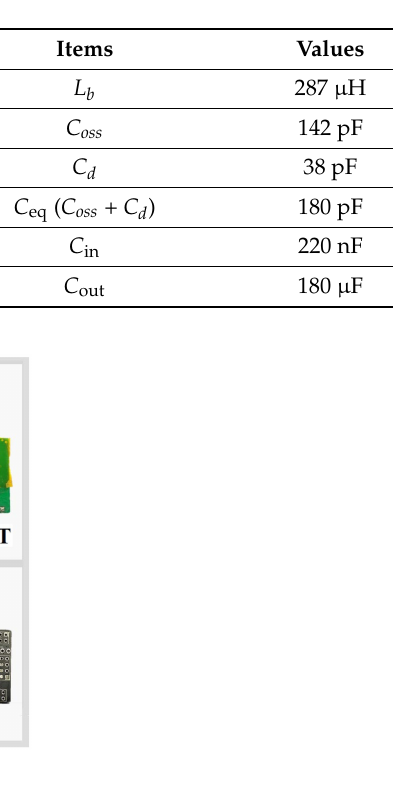
Table 5. The main specifications of the prototype.